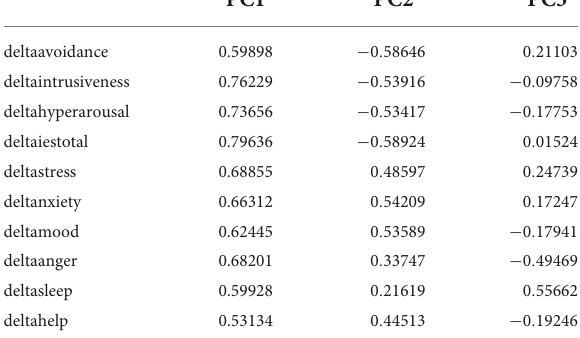
TABLE 6 Loading